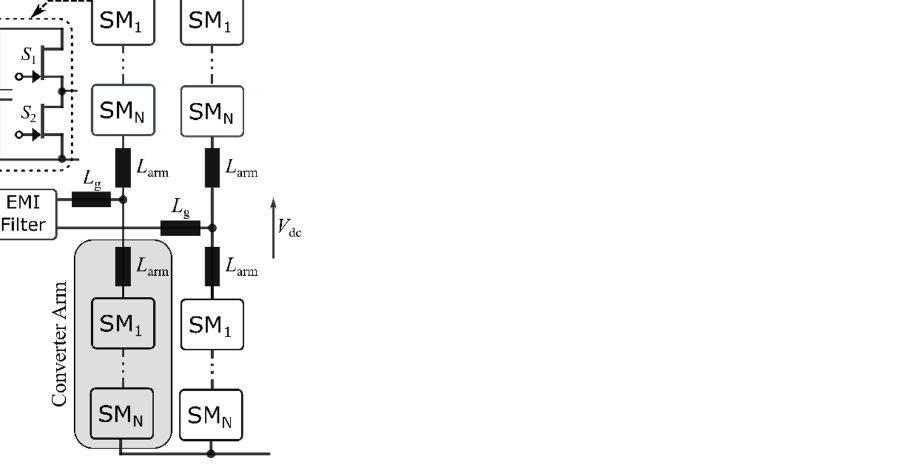
Figure 18. Generalized structure of single-phase N-level MMC-based AC/DC converter (derived from